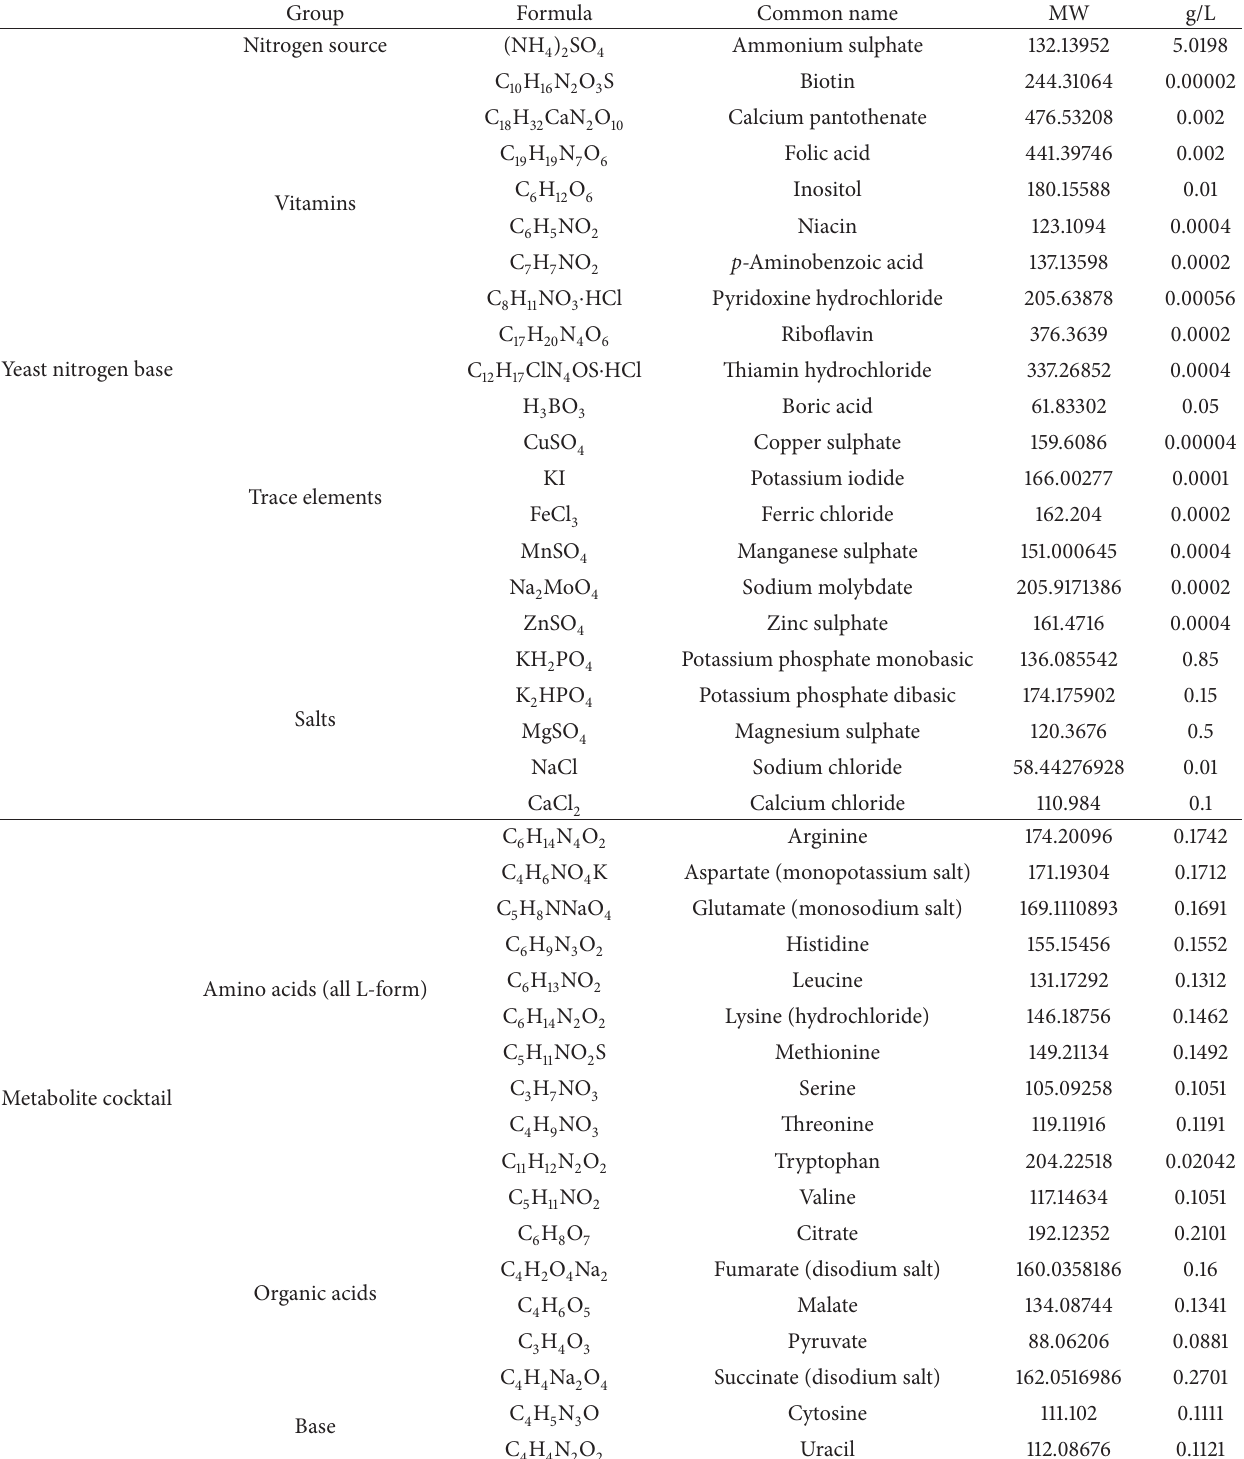
Table 1: Media composition used for metabolic footprinting